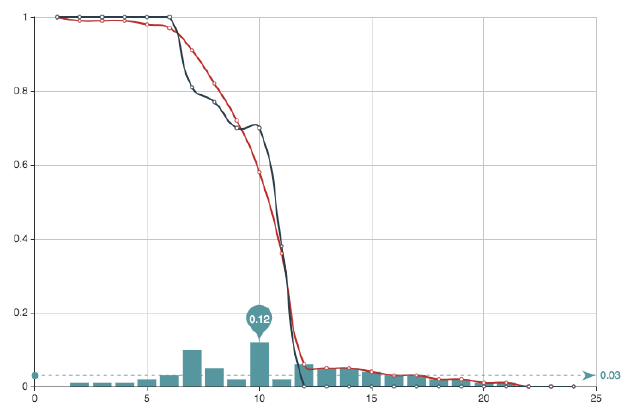
Figure 9. Survival function using genetic